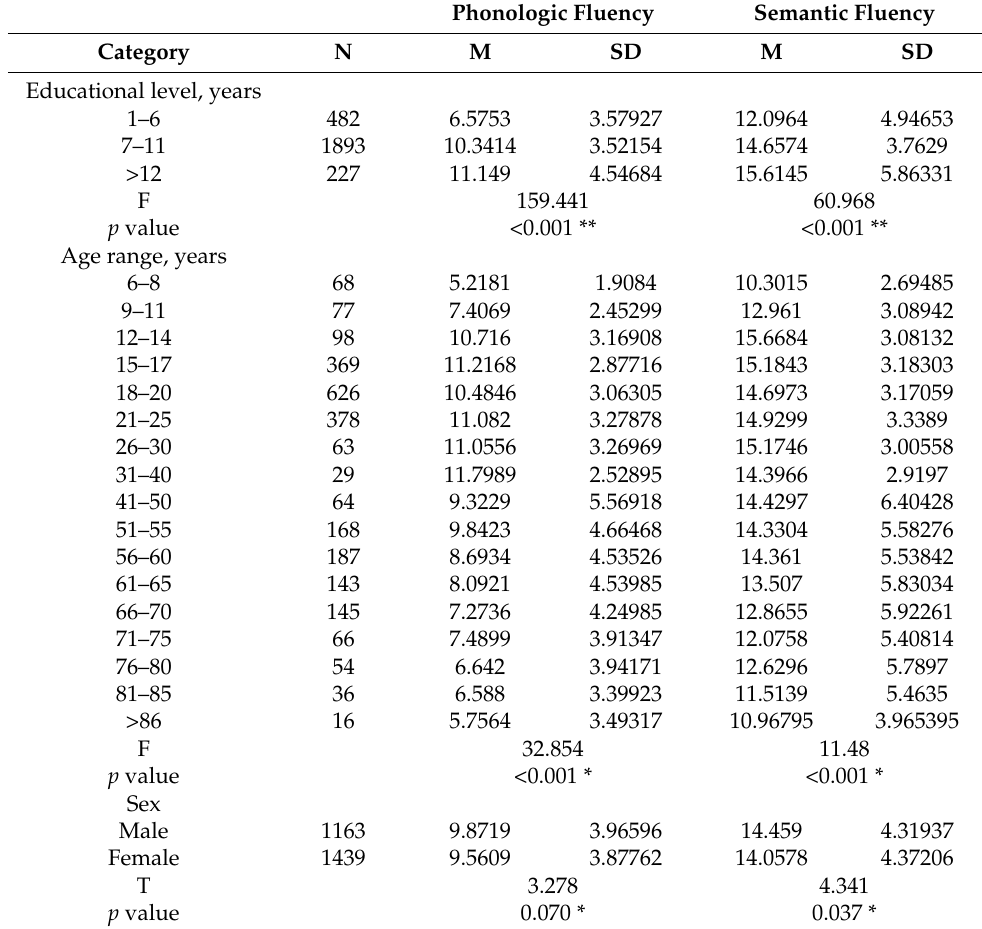
Table 3. Total phonologic and semantic verbal fluency scores according to educational level (years), age range (years), and sex. Multivariate analysis of variance (MANOVA): p < 0.05 *, p < 0.01 **.